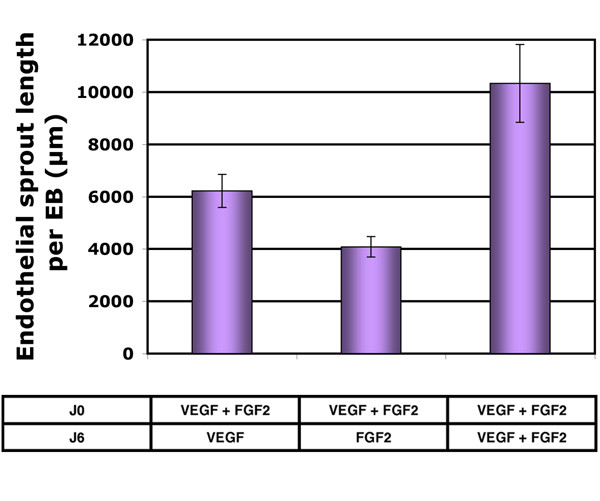
Quantitative analysis of endothelial sprouting in response to FGF2 and VEGF. CJ7 ES cells were first induced to differentiate at day 0 in the presence of both VEGF (50 ng/ml) and FGF2 (100 ng/ml). For the second growth factor addition at day 6, VEGF (50 ng/ml) and FGF2 (100 ng/ml) were added alone or in combination. The mean total sprout length of EBs exhibiting endothelial sprouts (angiogenic EBs) was measured at day 11, after CD31 immunostaining, and image analysis with MetaMorph Offline software. Data represent the mean values ± SD resulting from at least 25 angiogenic EBs obtained in one differentiation experiment.